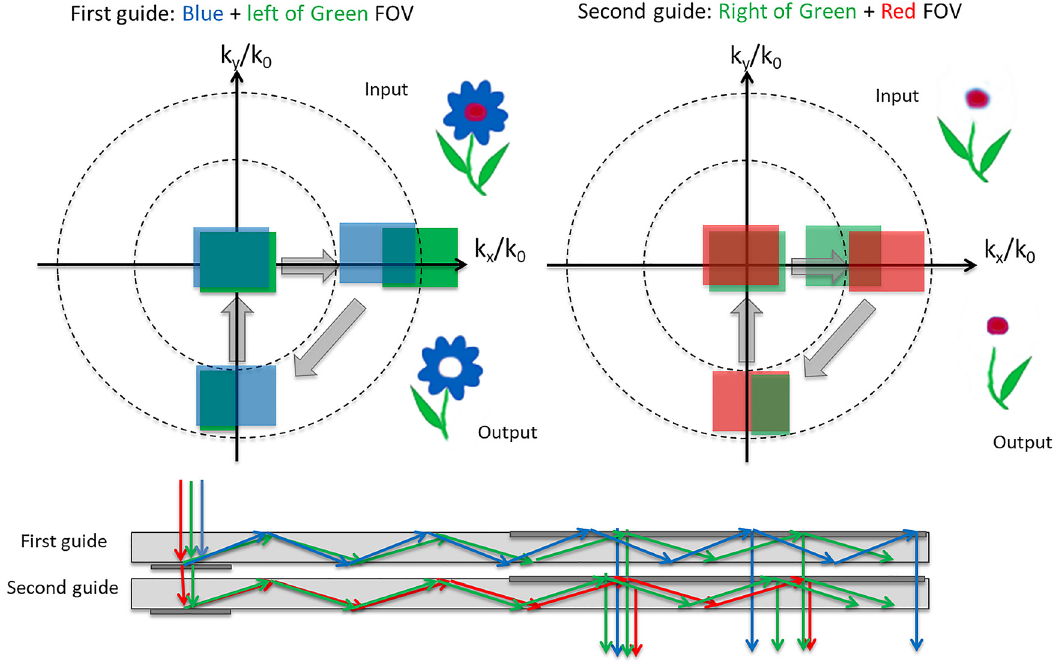
Figure 34: Two-guide RGB waveguide combiner